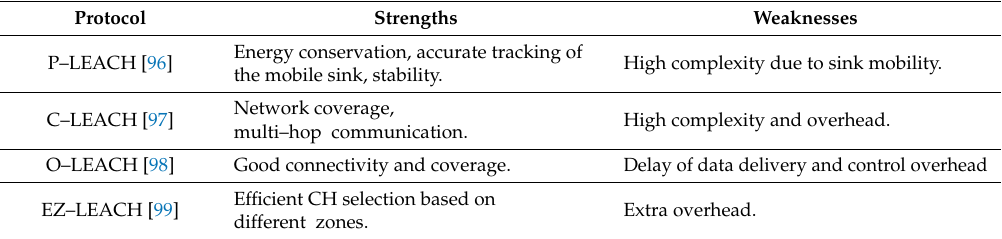
Table 8. Summary of network coverage-based cluster formation